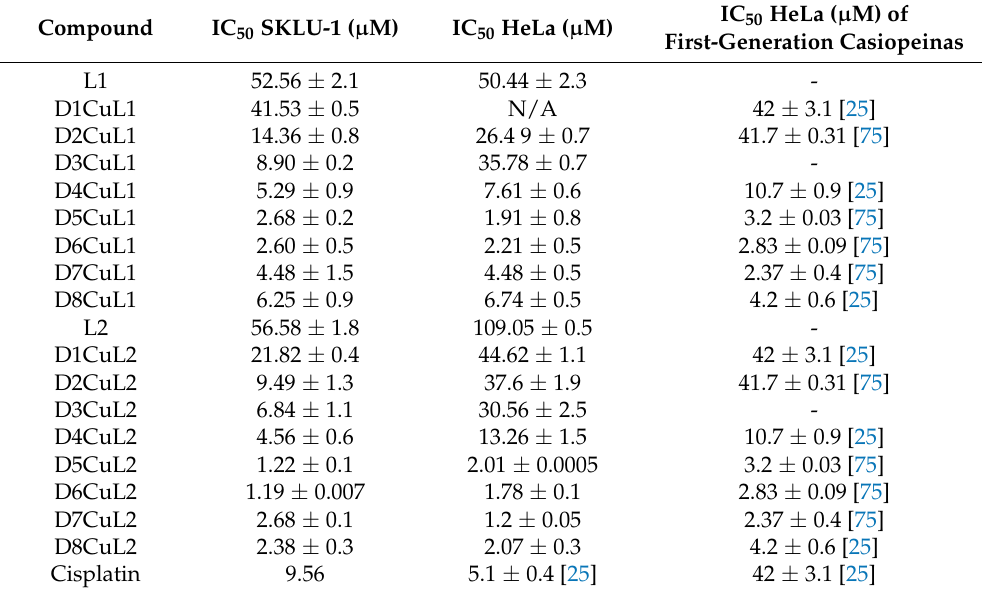
Table 5. Cytotoxicity assays for secondary ligands and complexes with L1 and L2 against SKLU-1 and HeLa cell